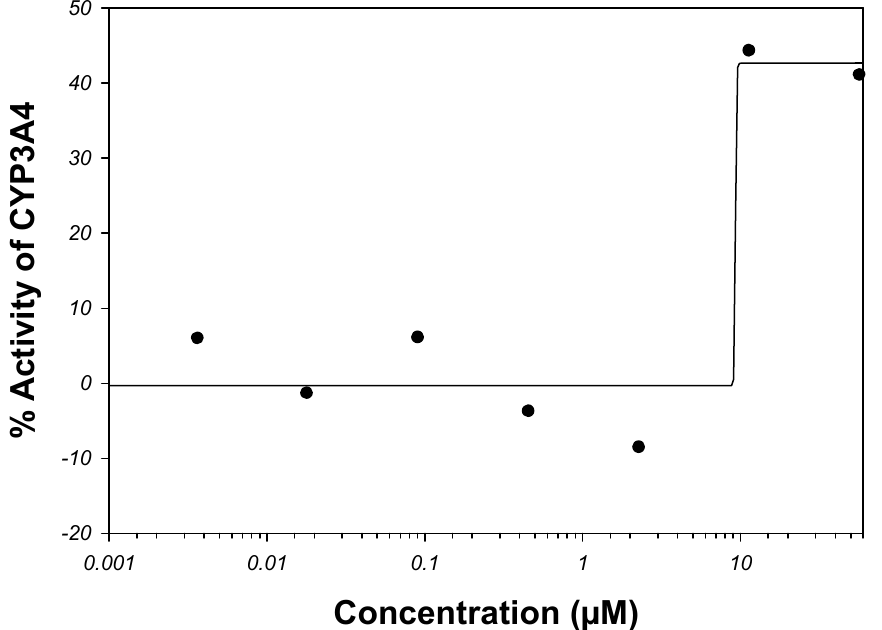
Figure 5. Dose-activity data of amiodarone as reported in PubChem ™ bioassay AID 884 [68,107]. A four-parameter Hill equation was fitted to the